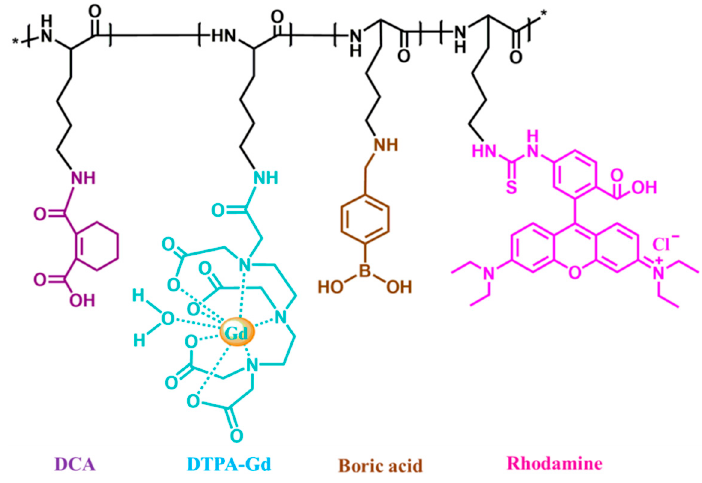
Figure 1. Schematic of tumor-targeting contrast agent PLL-B-DTPA-Gd-Rodamine-DCA. A series of functional groups, such as small molecule contrast agents (Gd 3 + ), fluorescent dye (Rhodamine) and tumor-targeting group (boric acid groups) B were conjugated with the amine groups on the side chain of polylysine (PLL). The 3,4,5,6-tetrahydrophthalic anhydride (DCA) was also conjugated to neutralize the extra amine groups in PLL to make the whole agent exert negative charges.